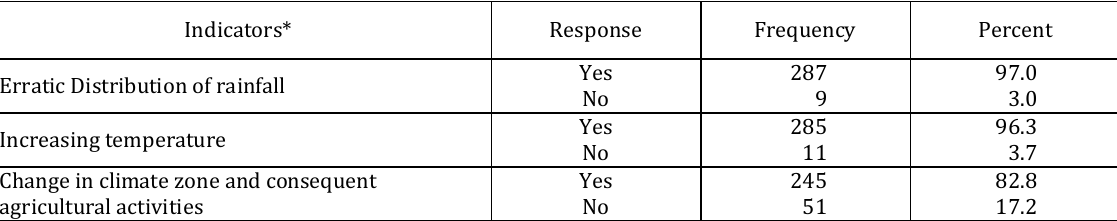
Table 4. Indicators of climate change manifestations (Source: Survey, April 2018)